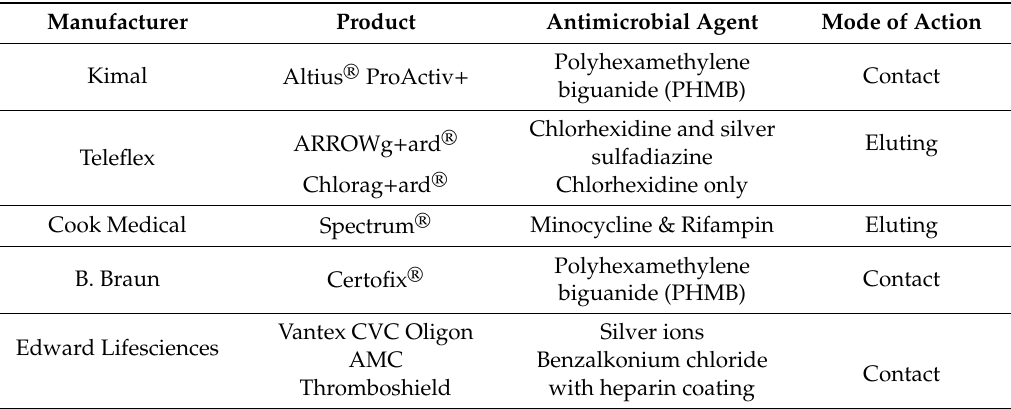
Table 3. Commercial catheter incorporating antimicrobial / antifouling